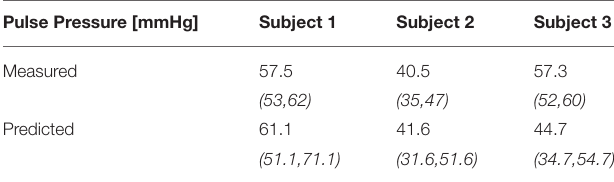
TABLE 8 | Comparison between the pulse pressure (PP) values measured via a cuff placed in the arm and the PP values predicted as a result of the cardiovascular parameters estimated via the proposed EA